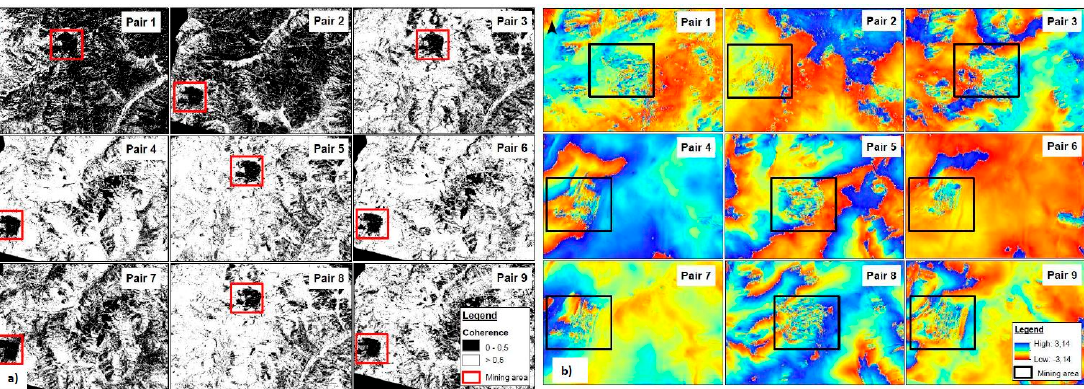
Figure 3. ( a ) Binary coherence mask; black: coherence < 0.5, withe: coherence ≥ 0.5; ( b ) Interferograms in the study